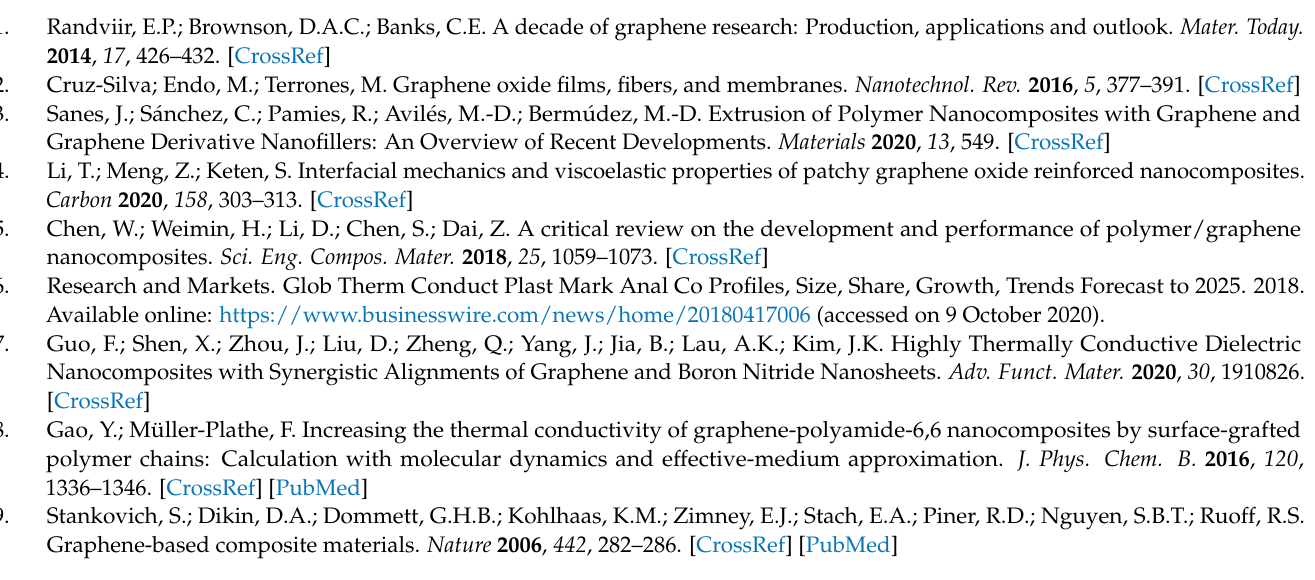
Table S1: Results of the elemental analyses of the parent GO and the GO samples decorated with polymer brushes together with the calculated polymer content, Table S2: Mechanical properties of the PA6/GO_PNVCL and PA6/GO_PNVP composites containing 1% of the decorated GO samples, Figure S4. Representative stress-strain curves obtained for PA6 and respective